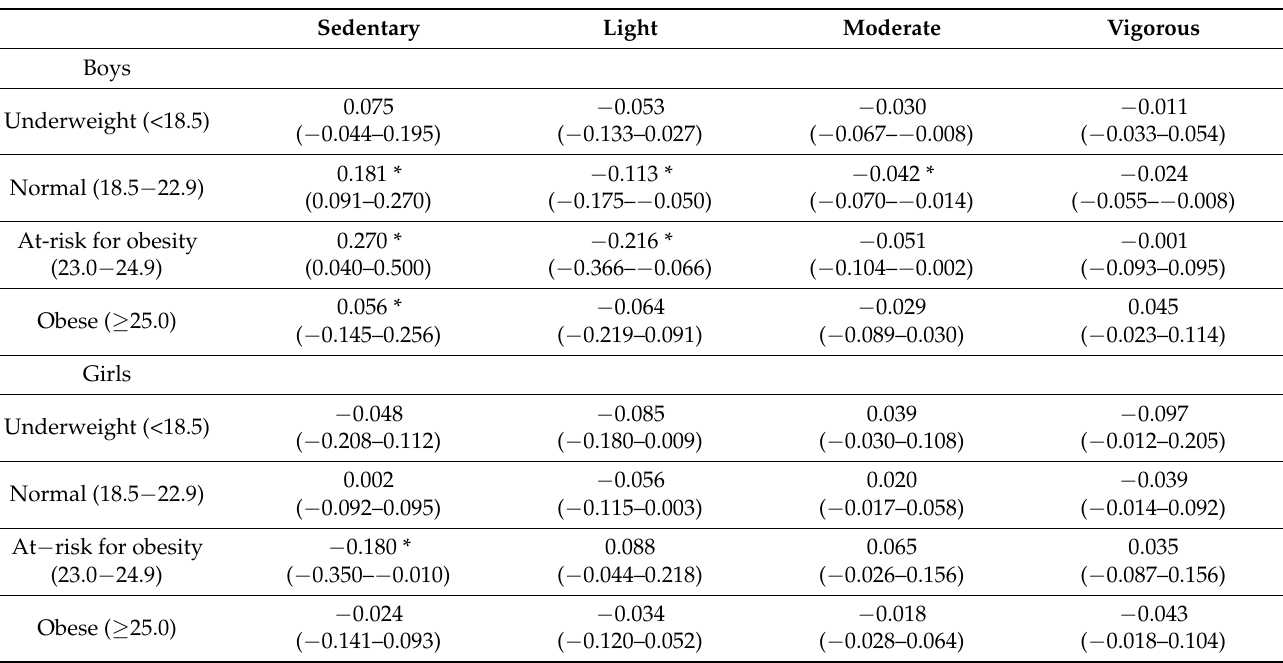
Table 4. Differences in physical activity time by free activity time in physical education class for each obesity